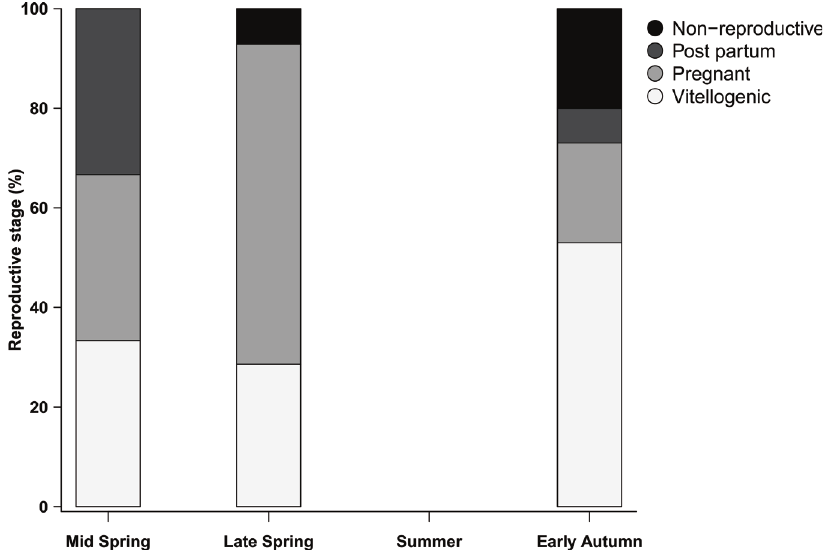
Figure 4. Percentage (%) of the reproductive stages of adult females through the seasons in Phymaturus extrilidus